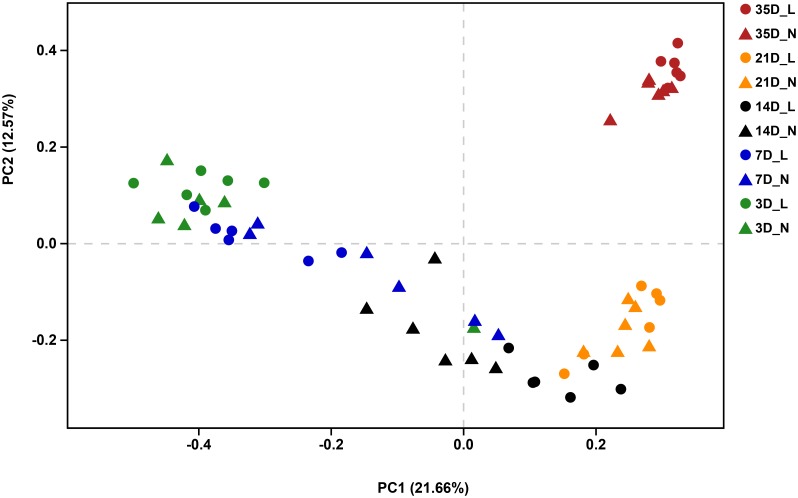
Principal coordinates analysis (PCoA, Bray–Curtis distance) plot of the gut microbial community structure by sampling time and birth weight status. n = 6 per group. L, low-birth-weight; N, normal-birth-weight.